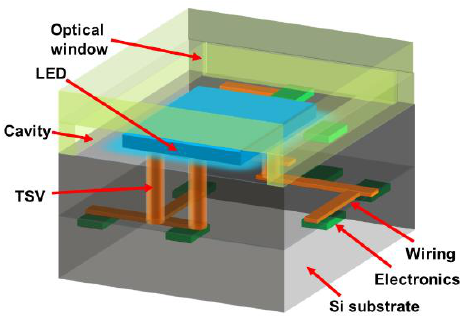
Figure 8. Schematic of a 3D-integrated light-emitting diode (LED) with anodically bonded optical